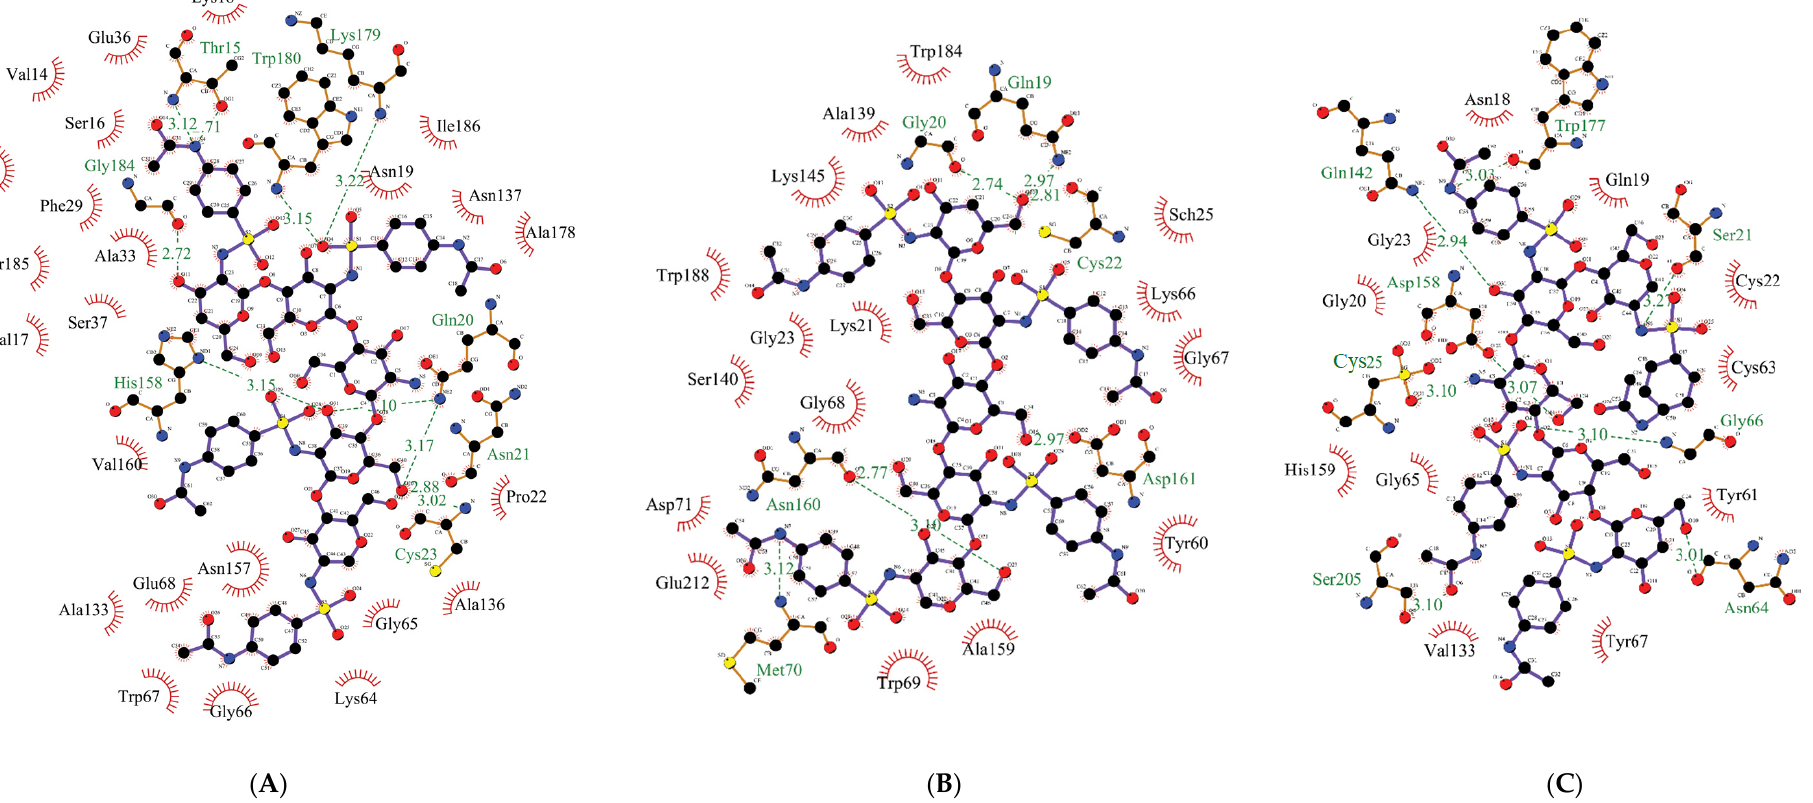
Figure 3. Bonds (indicated by dashed lines) and interactions between the molecules of bromelain ( A ), ficin ( B ), and papain ( C ) and 2-(4-acetamido-2-sulfanilamide) chitosan.